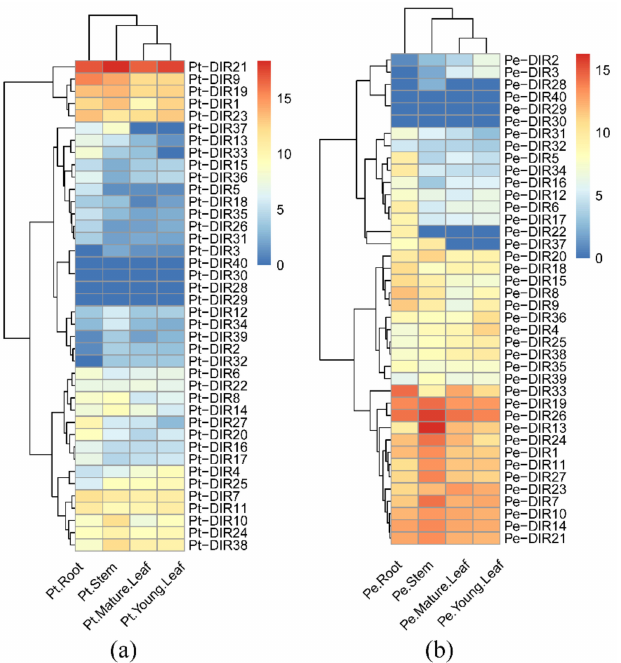
Figure 8. Expression profiles of DIR genes in various tissues (root, stem, young leaf, and mature leaf) of P. trichocarpa and ‘Nanlin 895’ by heatmap. ( a ) Tissue-specific expression of PtDIRs in P. trichocarpa . ( b ) Tissue-specific expression of PeDIRs in ‘Nanlin 895’. Data represent mean values ± the standard error (SE) of at least three independent biological replicates for